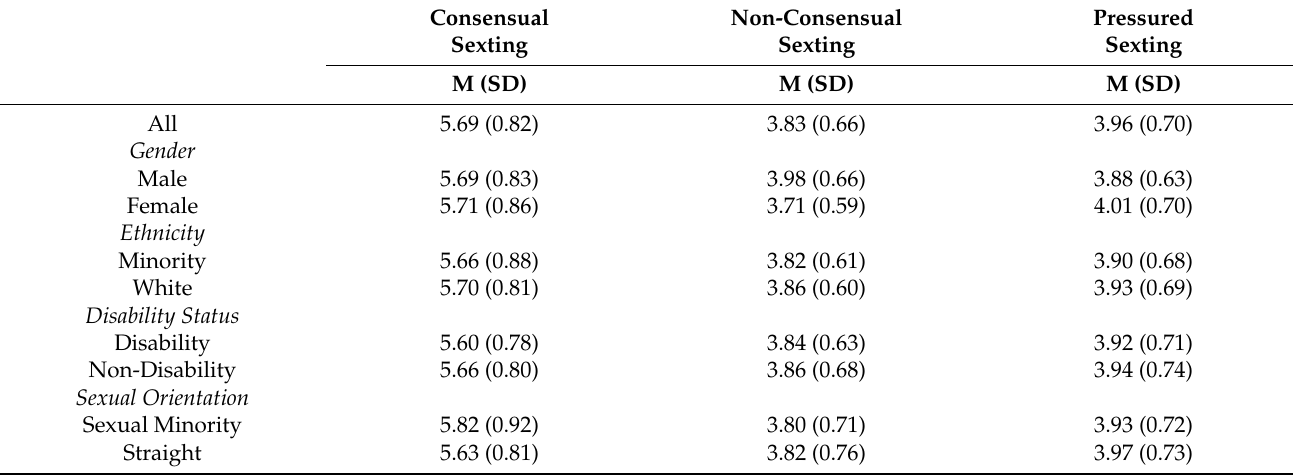
Table 1. Descriptive statistics of sexting types by demographic